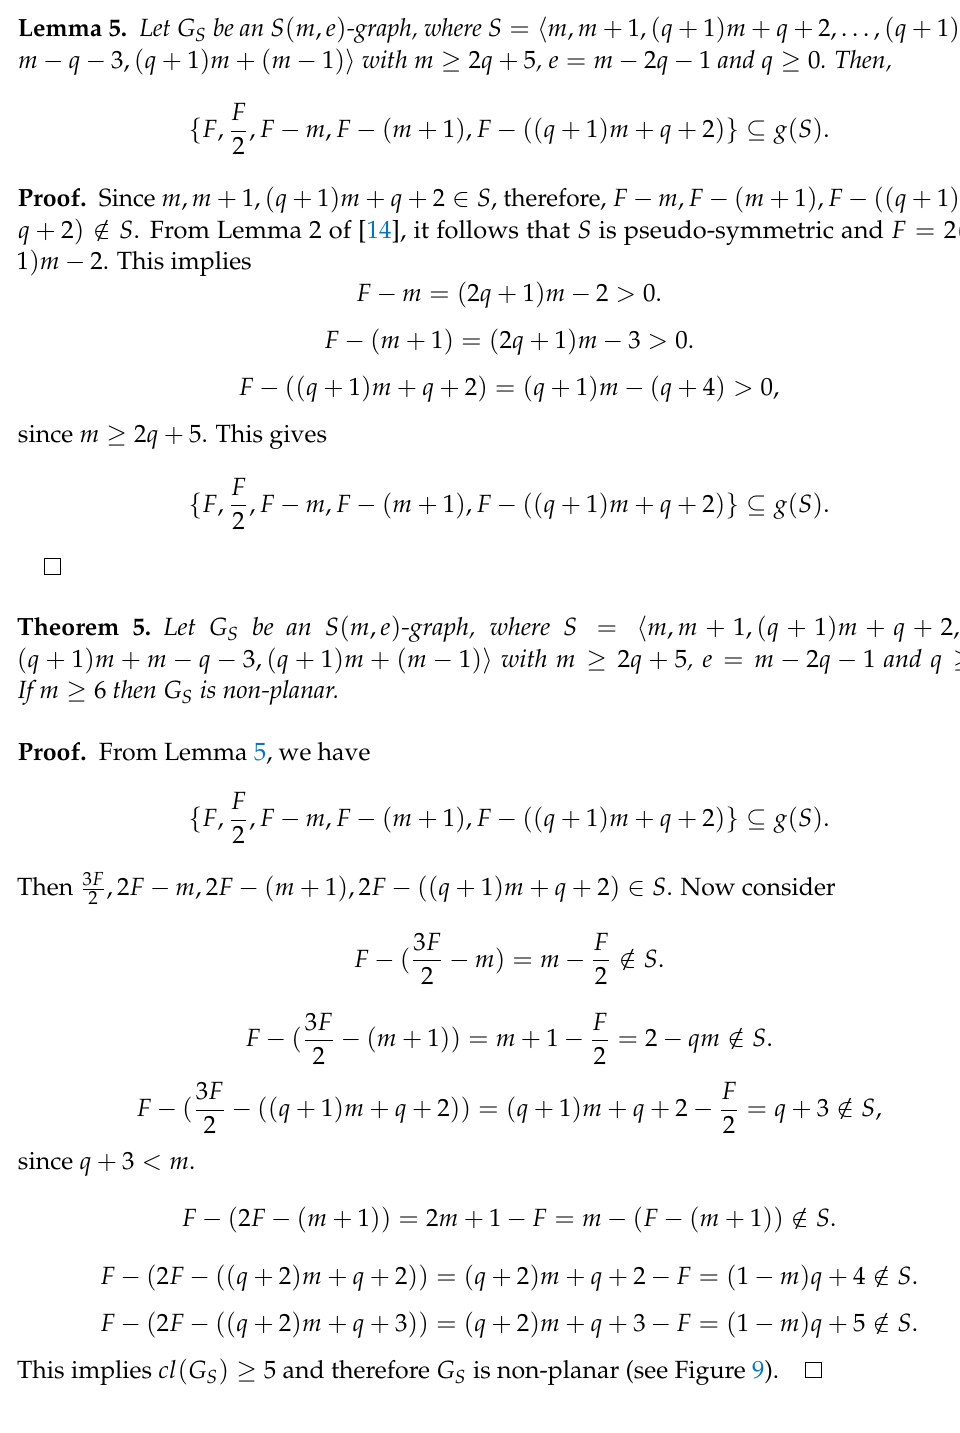
Figure 8. Minimum possible clique for the case m ≥ 2 q + 4, e = m − 2 q − 1 and q >